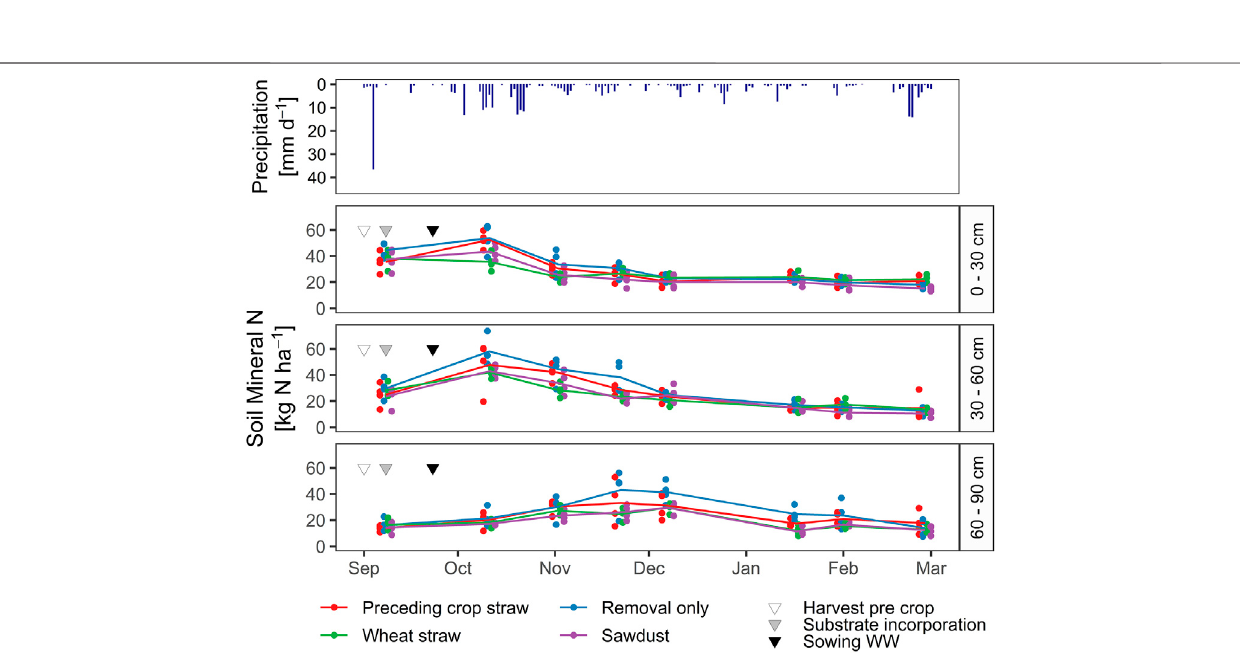
Frontiers in Environmental Science |